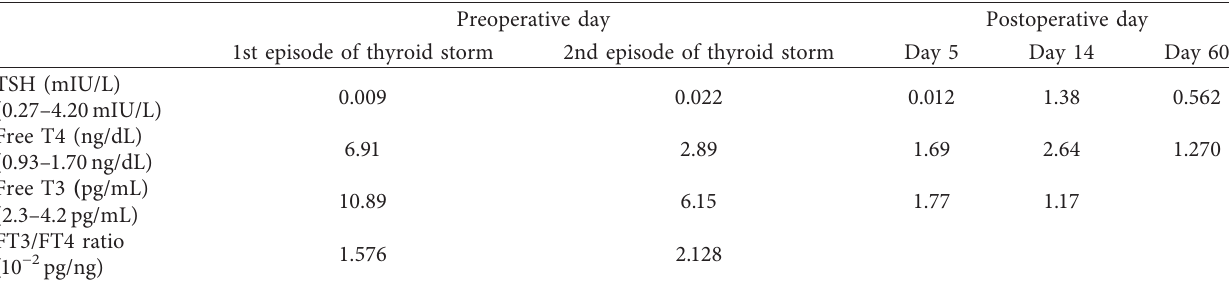
Figure 3: Specimen of the uterus showing the hydatidiform mole along the incision line of myometrium, a large mass of grape-like structures. Table 1: Evolution of thyroid